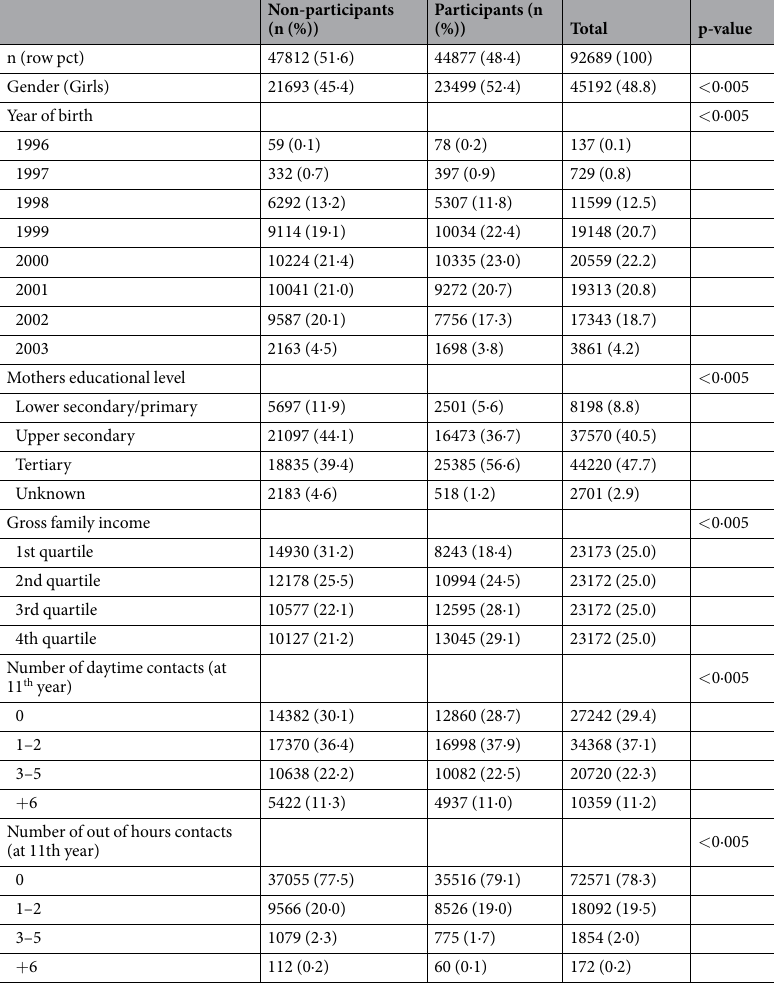
Table 1. Characteristics of participants and non-participants in the study based on the 11-year follow-up of the Danish National Birth